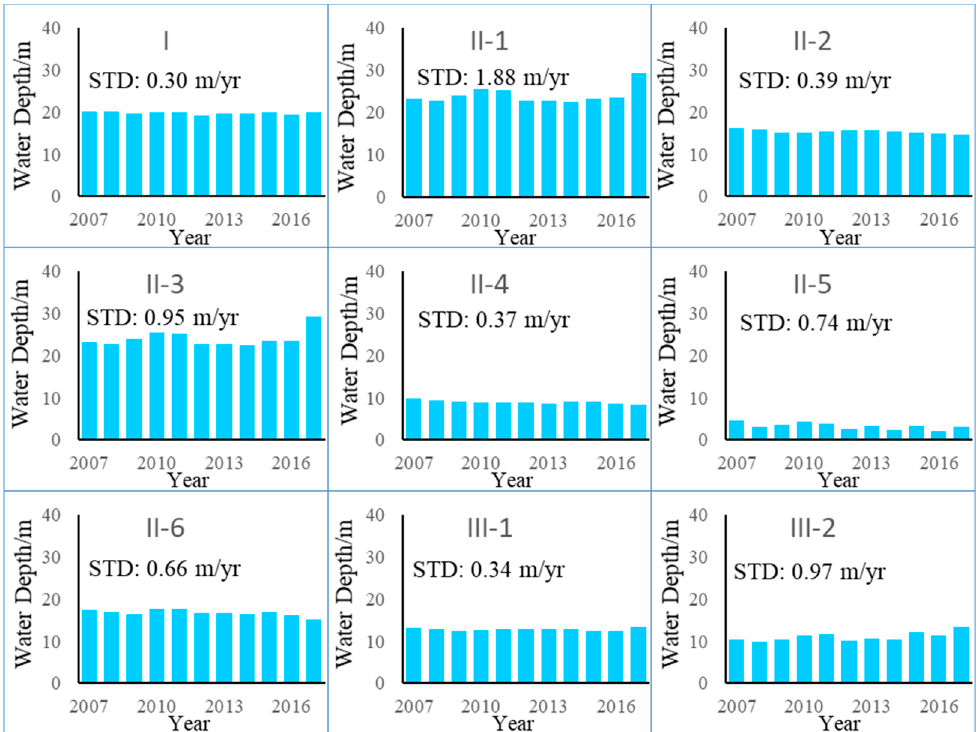
Figure 9. Groundwater depth of unconfined aquifers in different hydrogeological zones. STD: interannual standard deviation of unconfined water depth. The I, II-1, II-2, II-3, II-4, II-5, II-6, III-1, and III-2 subgraphs show the average groundwater depth of the unconfined aquifer in the I, II-1, II-2, II-3, II-4, II-5, II-6, III-1, and III-2 hydrogeological zones defined in Figure 2a.